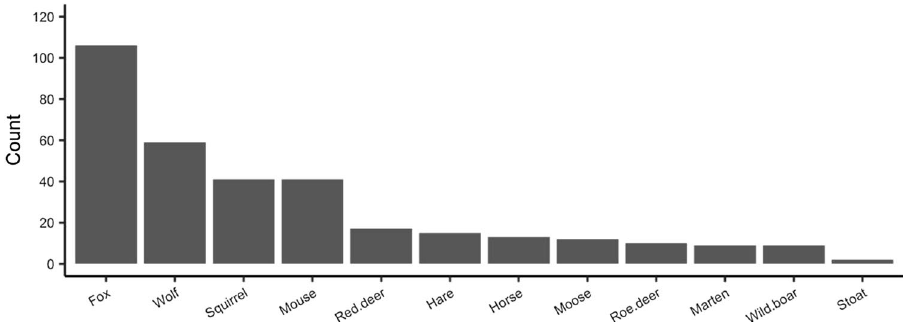
Figure 7. Count numbers per mammal species over the 145 studied transects.